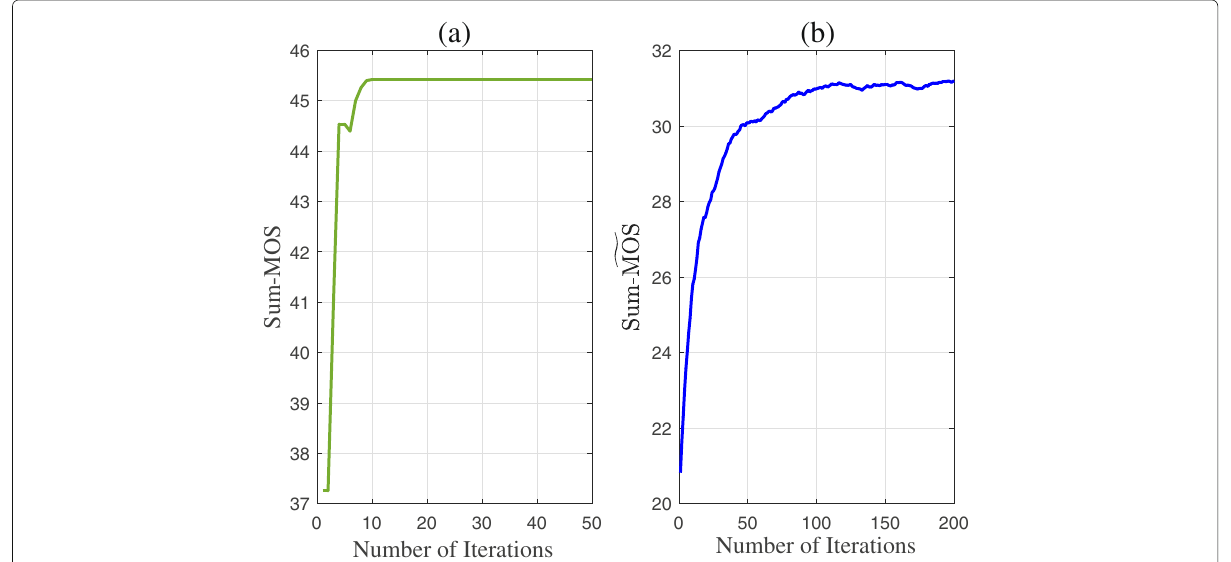
Fig. 4 The changing curves of the optimization objectives as the number of iterations increases by Algorithm 1 with fixed a (cid:5) : a in problem P ; b in problem ˜